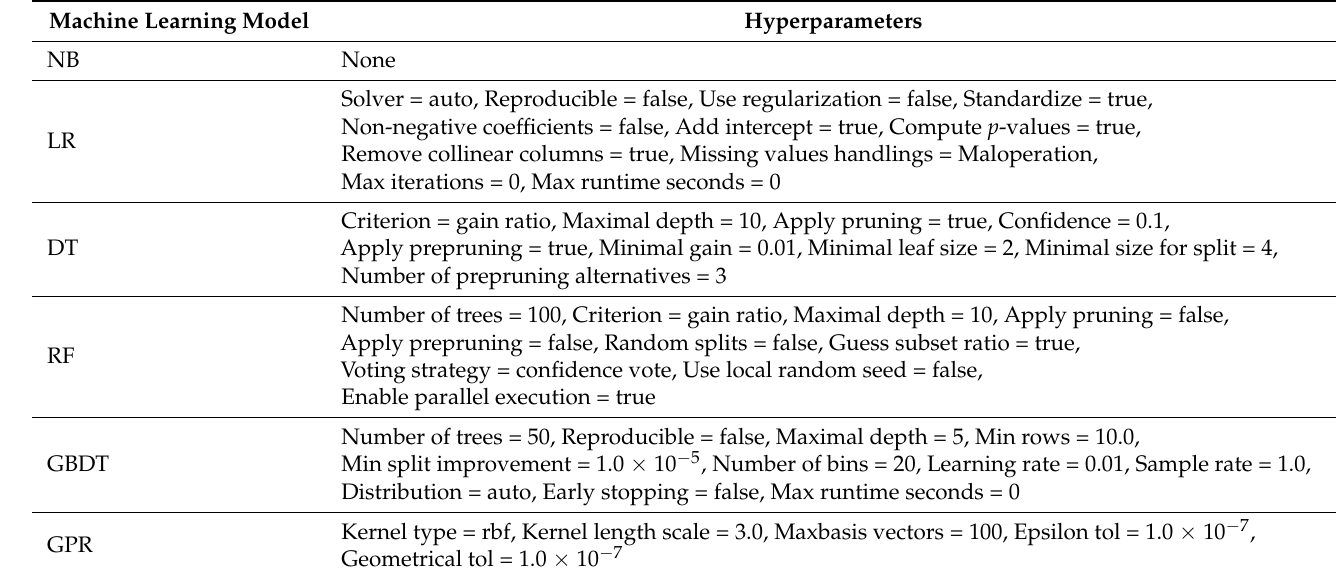
Table 3. Hyperparameters set by machine learning